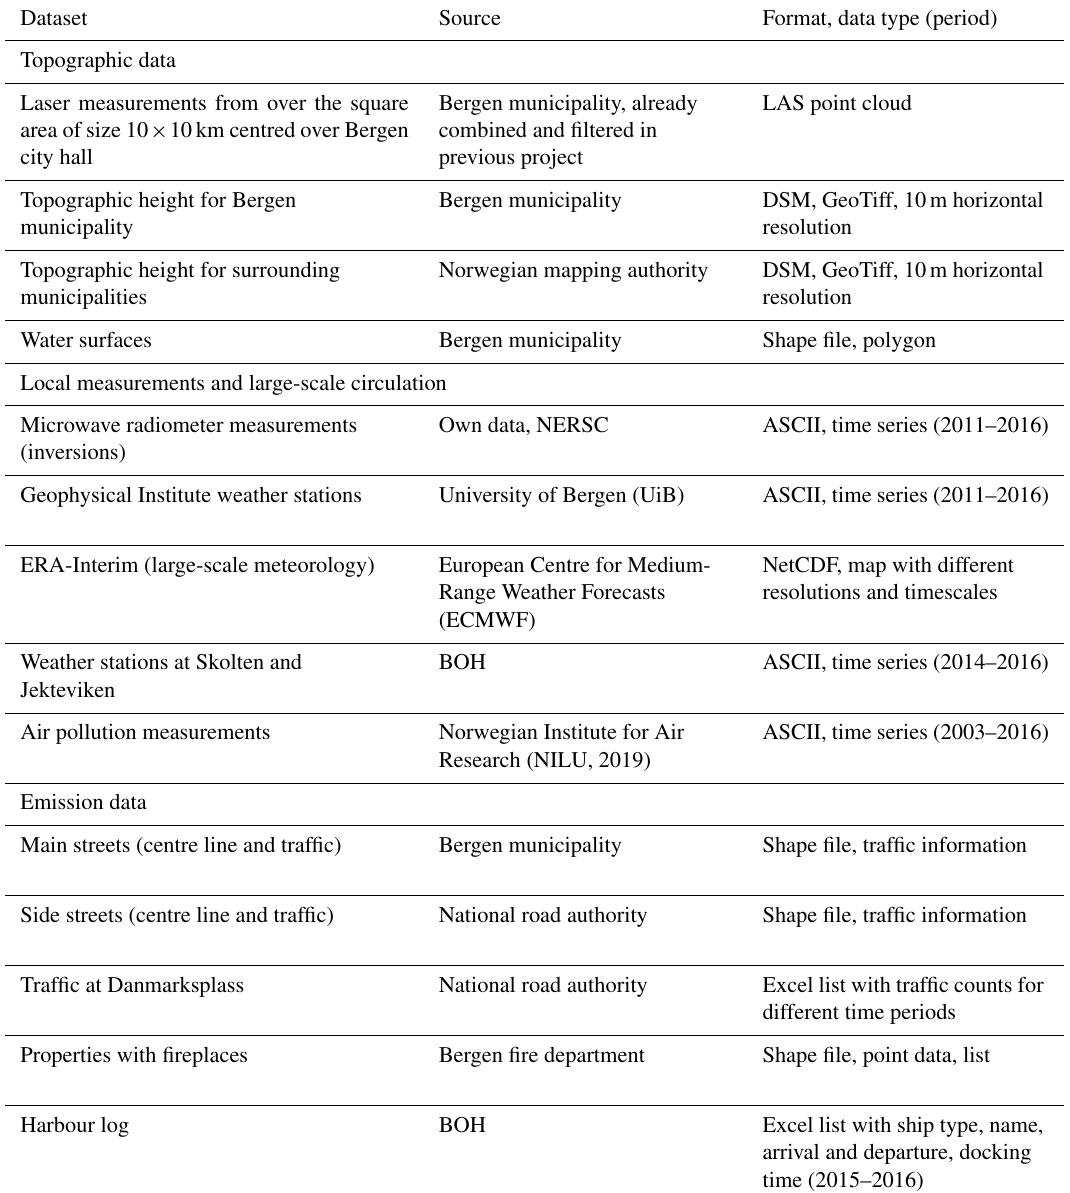
Table 1. Datasets used for this study. Dataset Source Format, data type (period) Topographic